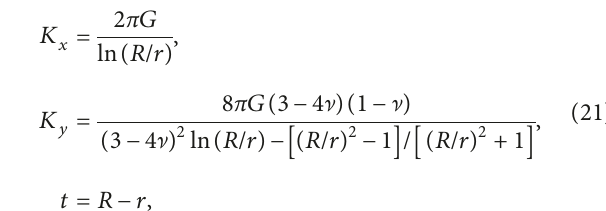
Figure 13: Time-acceleration curve. Table 2: Mechanical parameters of SISMO material.